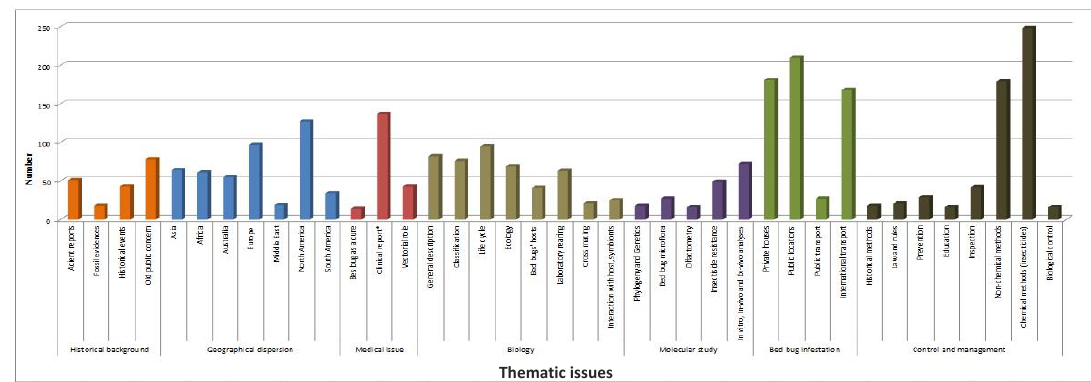
Figure 2. Thematic issues of the collected